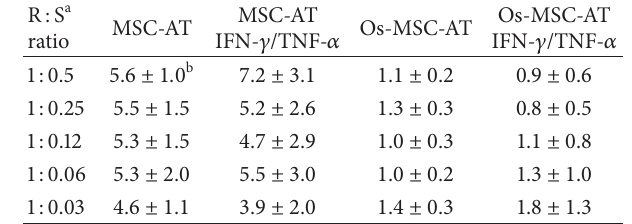
Table 1: MSC from BM after osteodifferentiation and licensing by IFN- 𝛾 and TNF- 𝛼 do not induce PBMC proliferation in allogenic conditions.